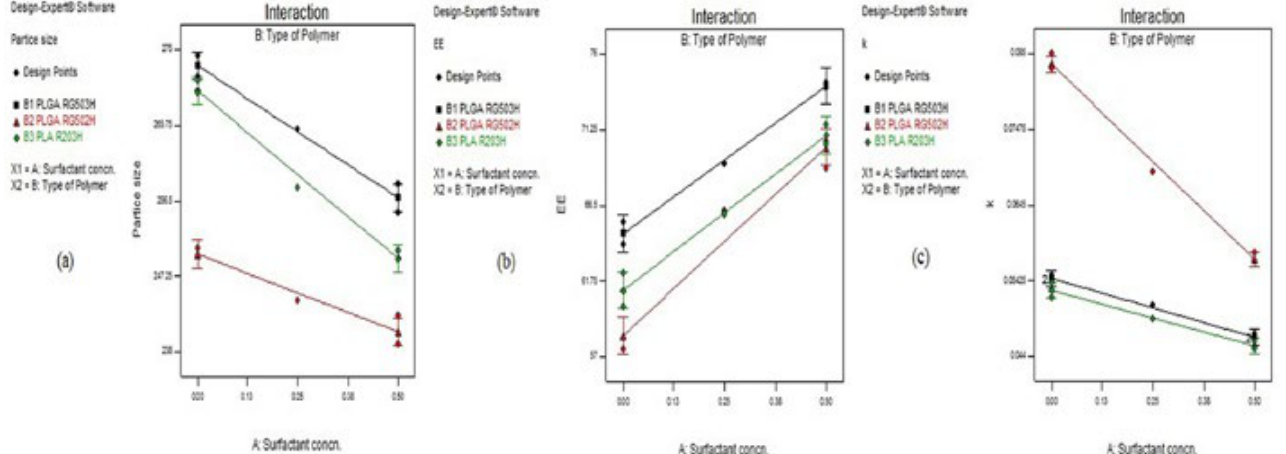
FIGURE 4 - Interaction plots showing the influence of surfactant concentration in primary emulsion and type of polymer on (a) particle size; (b) entrapment efficiency; (c) drug release rate